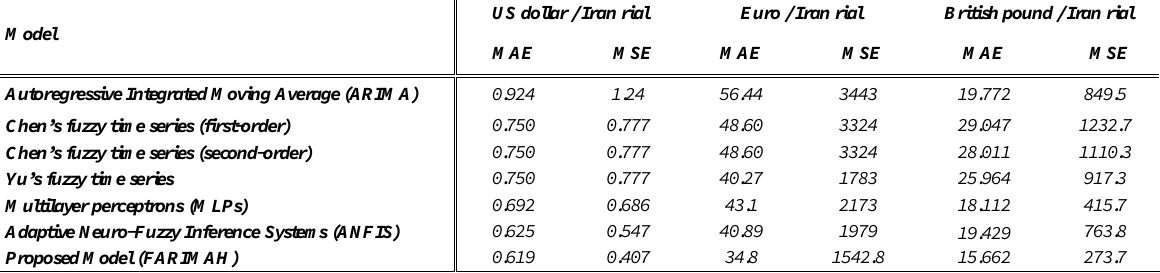
Table 7. Comparison of the performance of the proposed model with those of other forecasting models (point estimation).